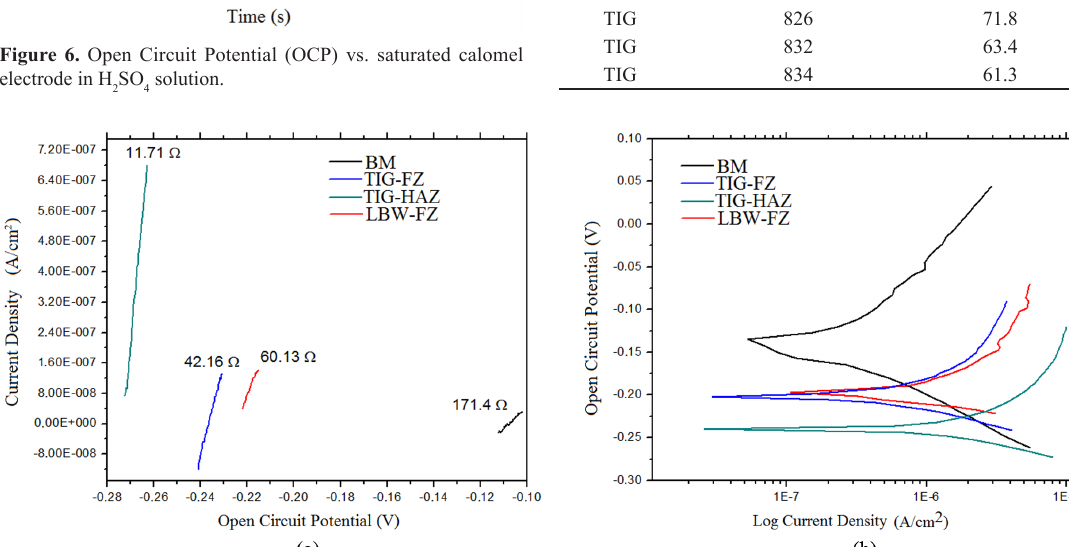
Figure 7. (a) Micropolarization and (b) Macropolarization vs. saturated calomel electrode in H